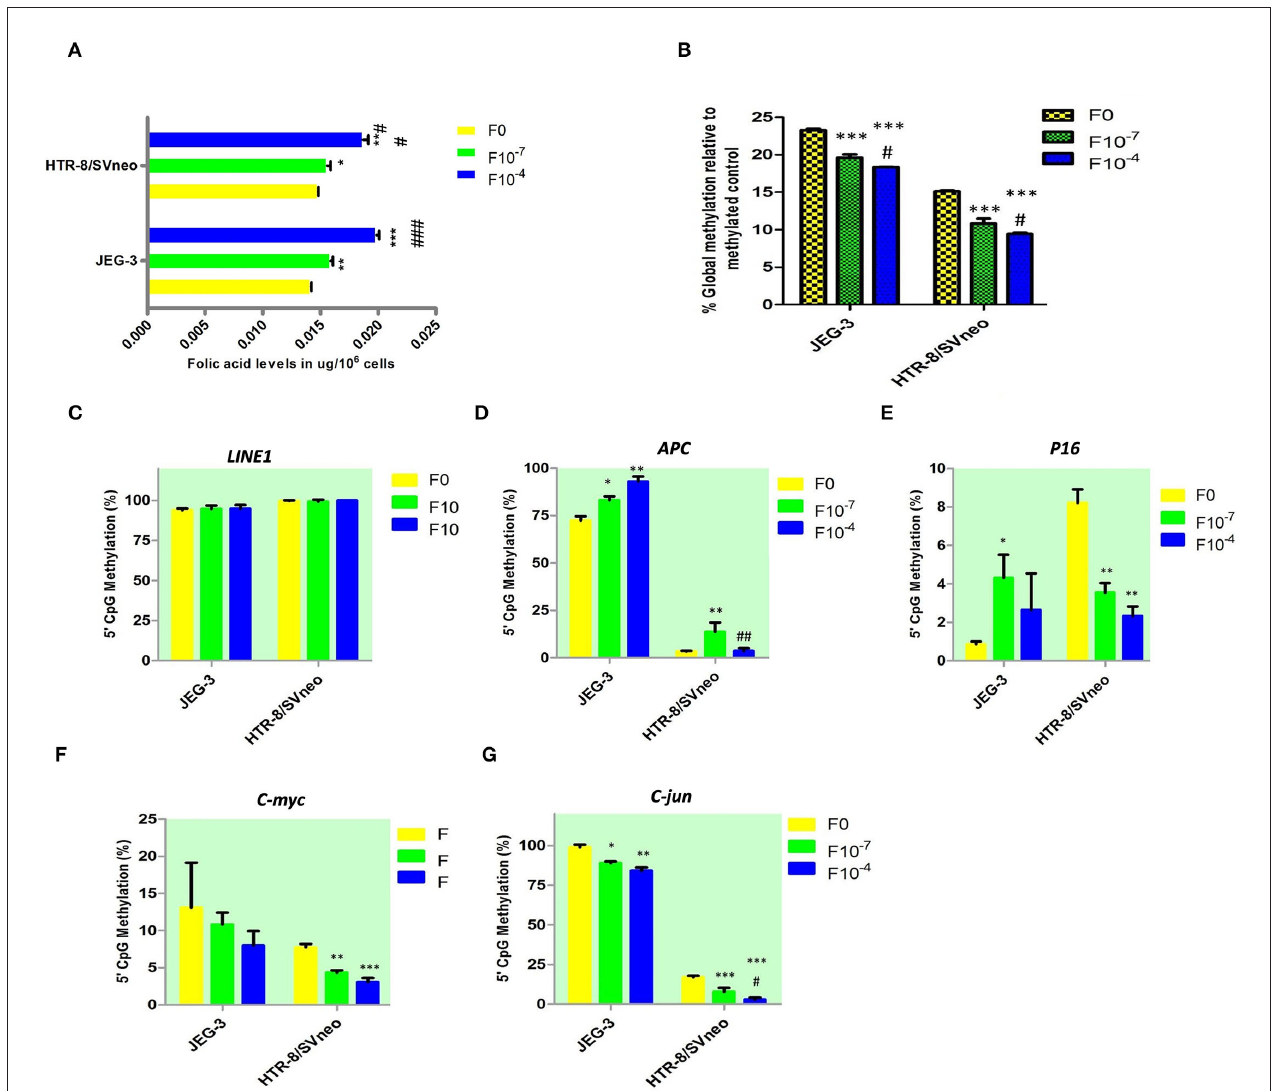
FIGURE 5 | Effect of folic acid supplementation on DNA methylation in JEG-3 and HTR-8/Svneo cell lines. (A) Relative folic acid levels after folic acid supplementation (B) Percentage global methylation upon folic acid supplementation (C–G) Effect of folic acid supplementation on 5’CpG Methylation (%) in (C) LINE1 promoter region, (D) APC promoter region, (E) P16 promoter region, (F) c-myc promoter region, and (G) c-jun promoter region. F0- without folic acid supplementation, F10 − 7 and F10 − 4 - folic acid supplementation at the concentration of F10 − 7 and F10 − 4 M respectively. The data are expressed as mean ± SEM of three experiments. * p < 0.05, ** p < 0.01, *** p < 0.001 with respect to the F0 control and # p < 0.05, ## p < 0.01, ### p < 0.001 with respect to the F10 − 7 treated